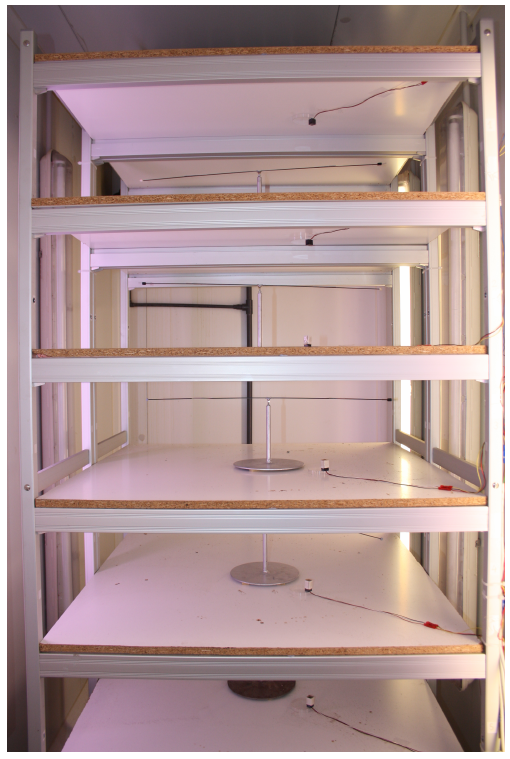
Figure 8. Rack composed of 5 flight mills.